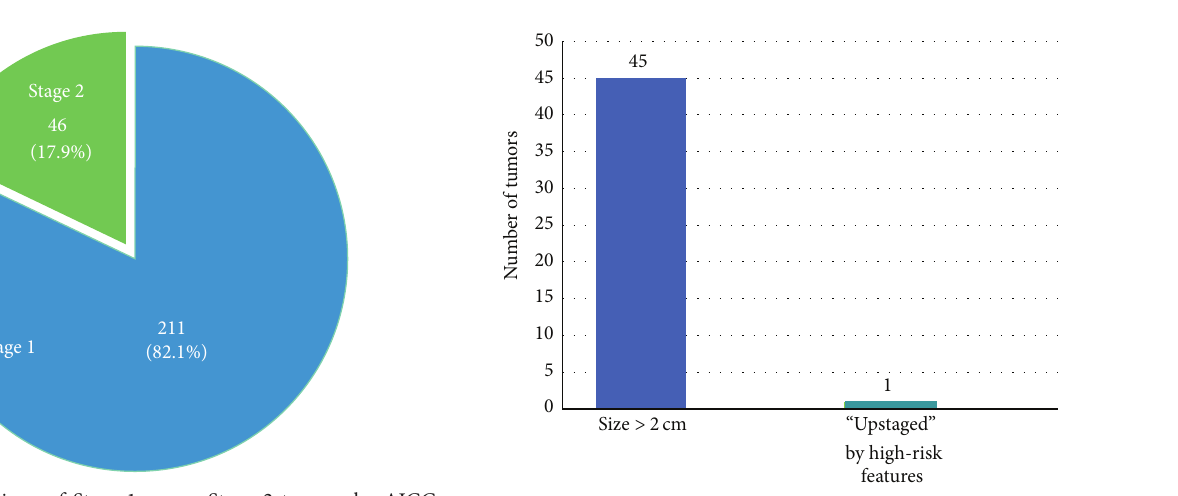
Figure 2: Factor(s) leading to Stage 2 designation by AJCC